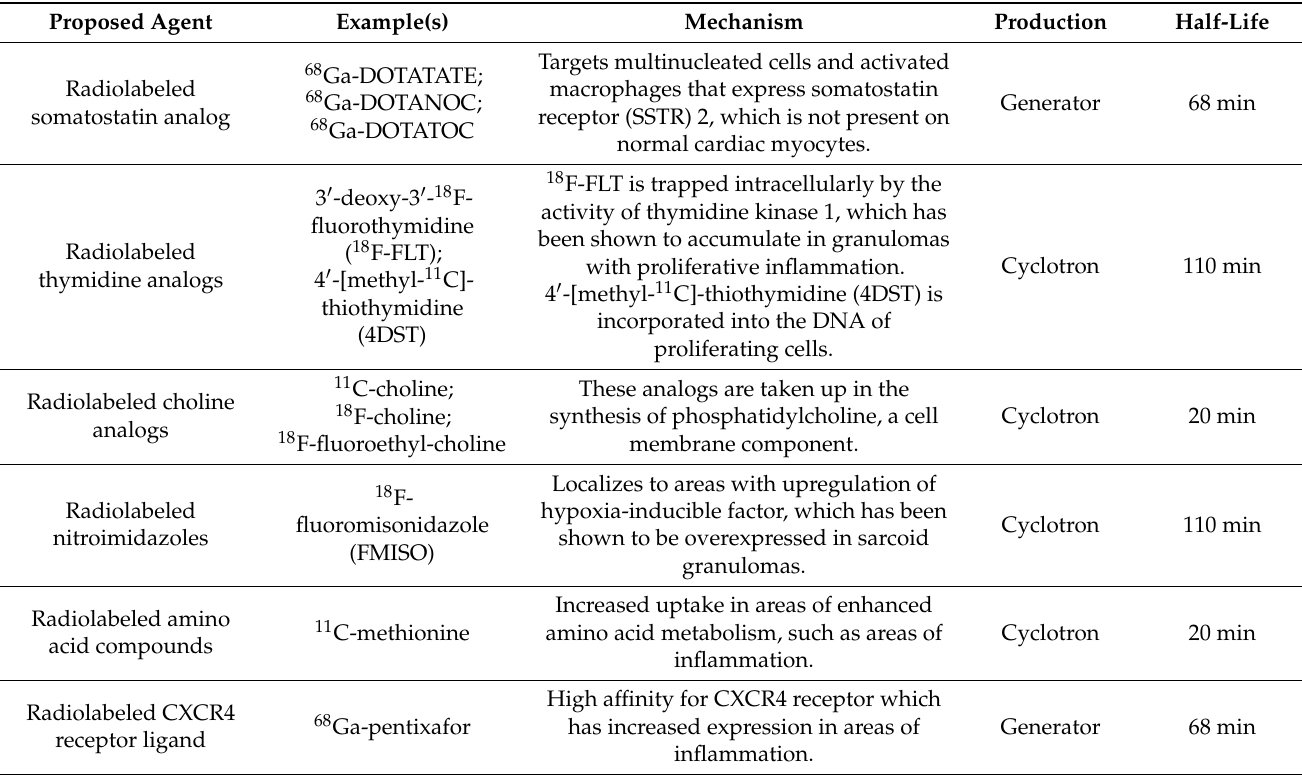
Table 1. Novel Radiopharmaceutical PET Agents for Imaging in Cardiac